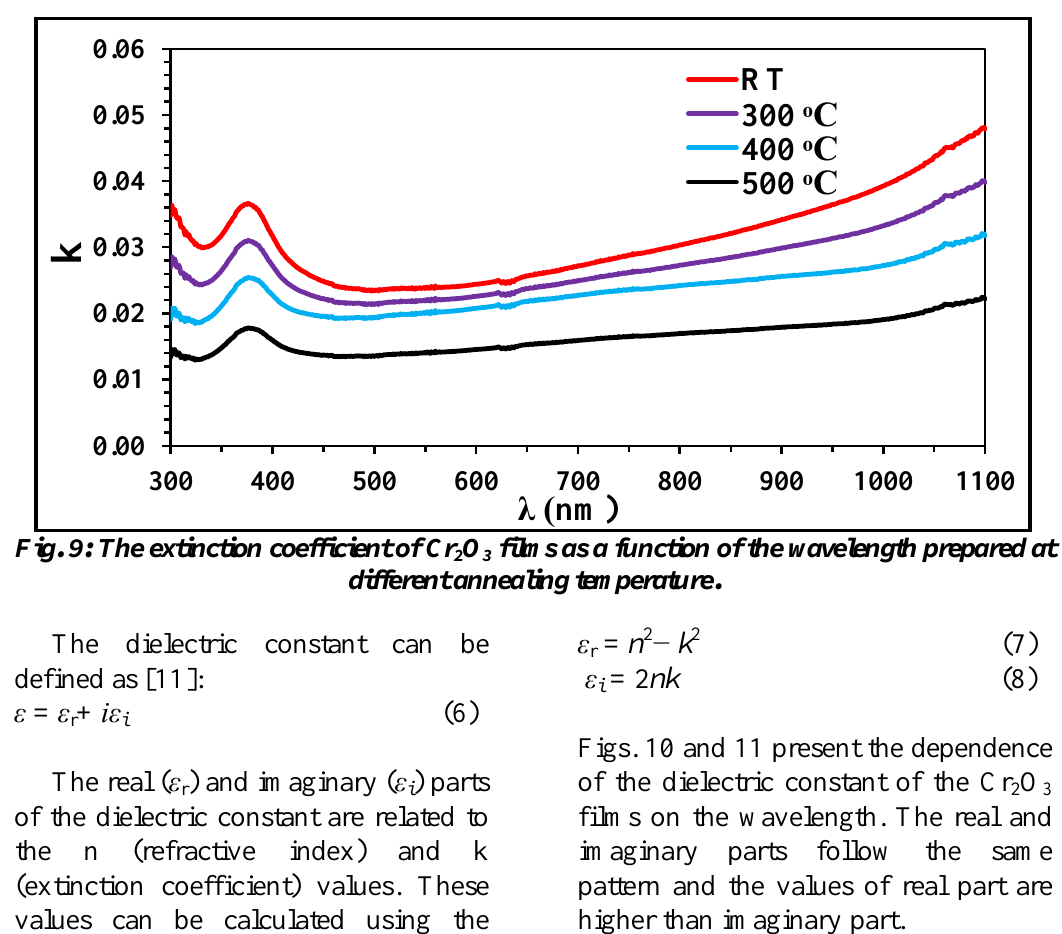
O films as a function of the wavelength prepared at 2 3 different annealing temperature.